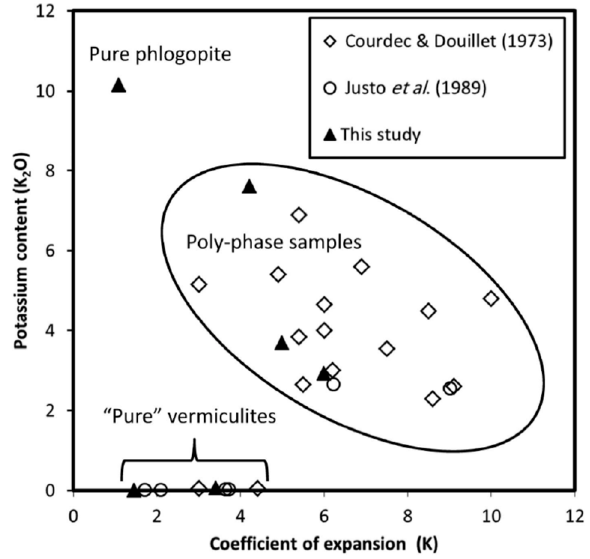
Figure 3. Relationship between potassium content and expansion rate, showing that vermiculites with more than one constituent phase (polyphase samples) show greater expansion rate in relation to “Pure” vermiculites